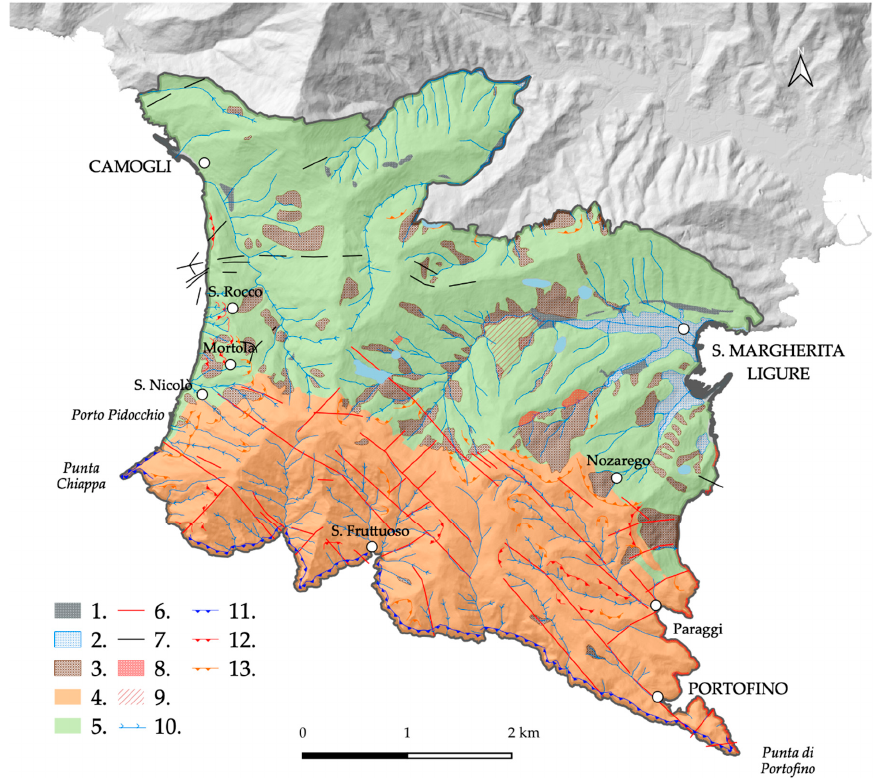
Figure 3. Geological and geomorphological sketch map of the Portofino promontory: 1. Anthropic deposits; 2. Alluvial deposits; 3. Debris covers; 4. Conglomerate of Portofino; 5. Flysch of Mt. Antola; 6. Fault and presumed fault; 7. Fold axis; 8. Areas affected by rockfalls and widespread shallow landslides; 9. Deep-seated gravitational slope deformation; 10. Downcutting talwegs; 11. Cliff; 12. Active landslide or degradation scarp; 13. Inactive landslide or degradation scarp.